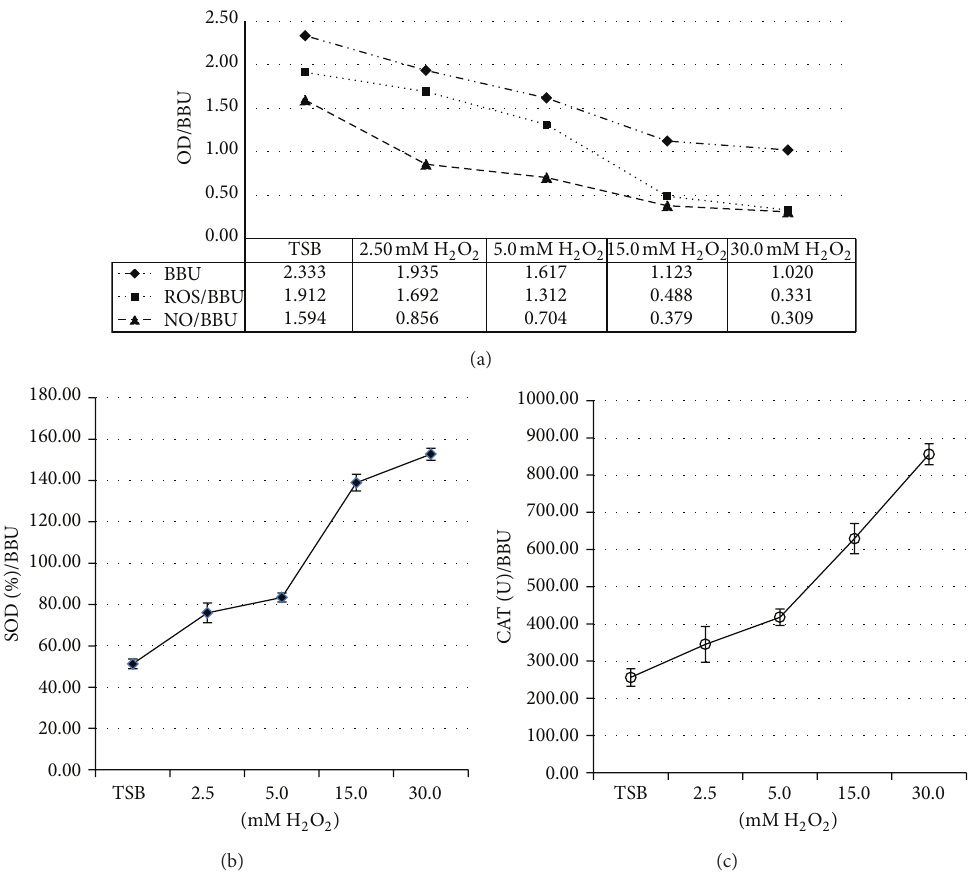
Figure 3: Biofilm formation with H 2 O 2 treatment (range of 2.5 to 30 mM) of strain N ∘ 1. (a) Biofilm biomass units (BBU) (- ⧫ -), relation of ROS and BBU (ROS/BBU) (- ◼ -), and NO and BBU relation (NO/BBU, nitrite expressed in 𝜇 M) (- 󳵳 -); (b) SOD activity (%)/BBU (- ∙ -); and (c) CAT (U)/BBU (- ∘ -). Each line shows the mean ± SEM of three independent